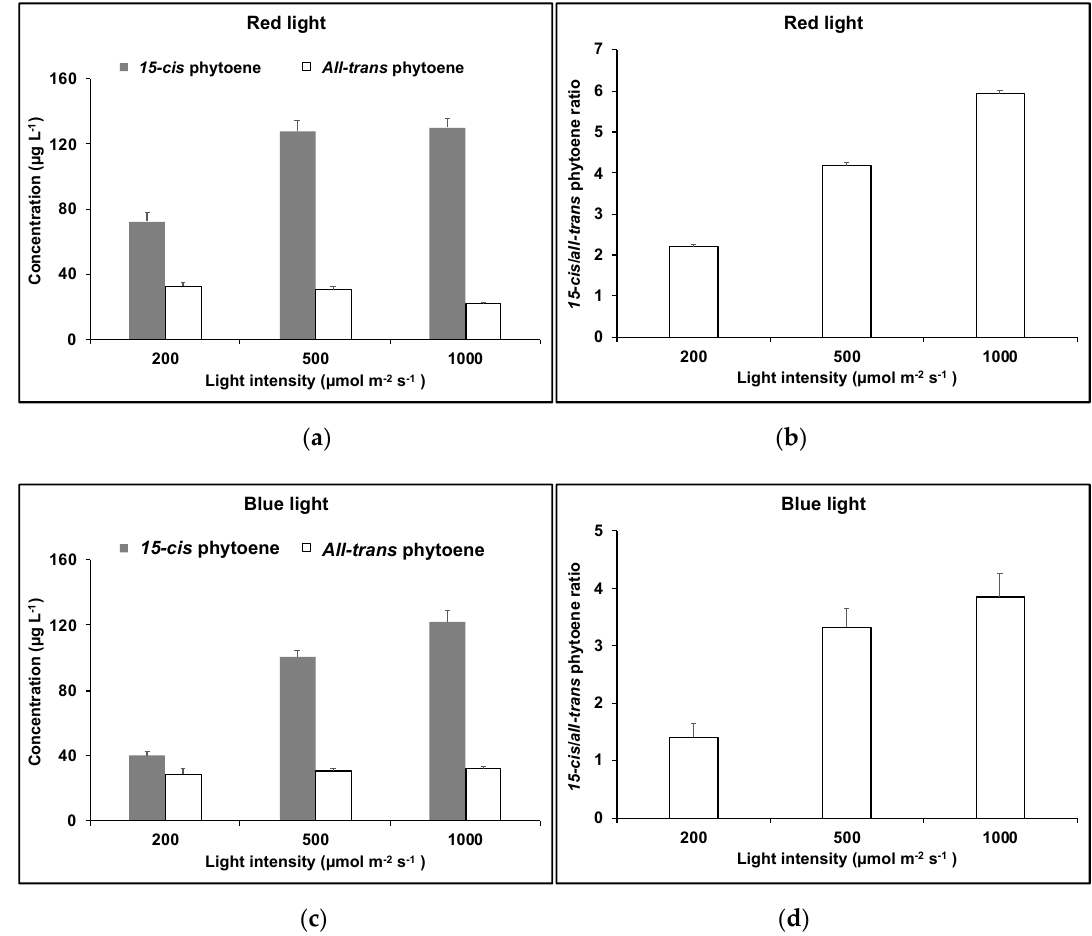
Figure 10. Phytoene isomeric composition in D. salina cultivated under ( a ), ( b ) red or ( c ), ( d ) blue light at different light intensities (200, 500 or 1000 µmol·m −2 ·s −1 ) for 48 h. Phytofluene was measured at 355 nm using HPLC. Only one phytofluene isomer was detected